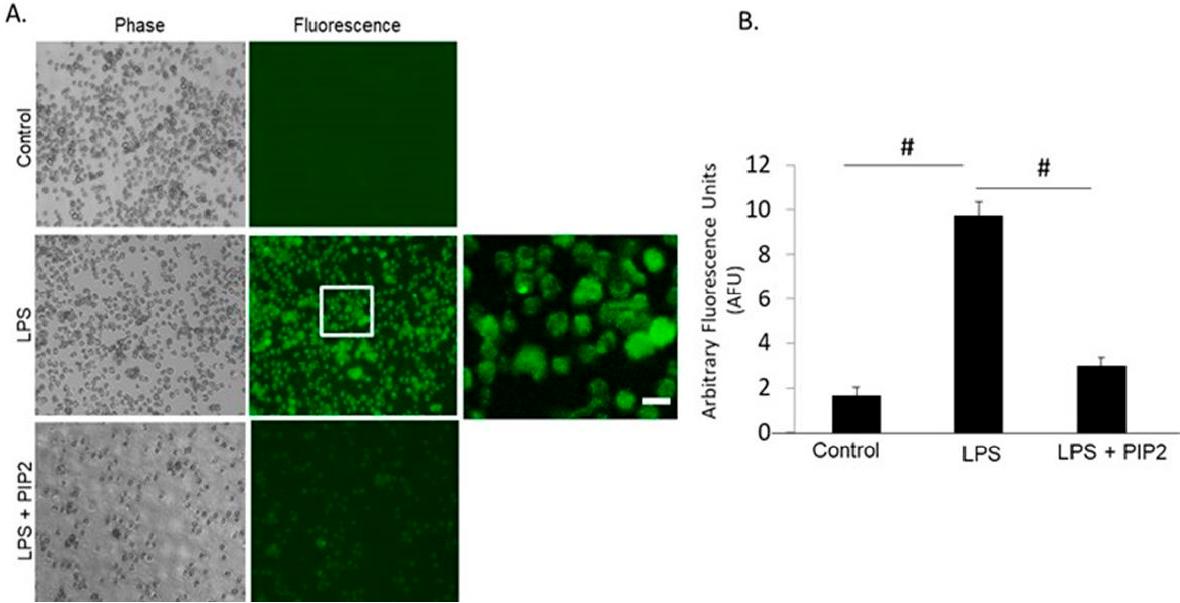
Figure 2. Inhibition of H 2 O 2 production by PIP-2 in HL60 cells. ( A ). Fluorescent images of HL60 cells under control (liposomes alone), LPS + liposomes, or LPS + PIP-2 in liposomes. Images were acquired at λ excitation = 488 nm. A. All images were acquired with the same exposure and acquisition settings. The area enclosed by the box in the middle panel is shown at higher magnification in the far-right panel. Scale bar is 10 µ m. ( B ). The integrated fluorescence intensity generated by HL60 cells across several microscopic fields ( n = 3) was quantified using MetaMorph Imaging software. Intensity of fluorescence was normalized to area. The data is expressed as mean ± SD for n = 3 independent experiments. # p < 0.001 for the indicated comparisons.